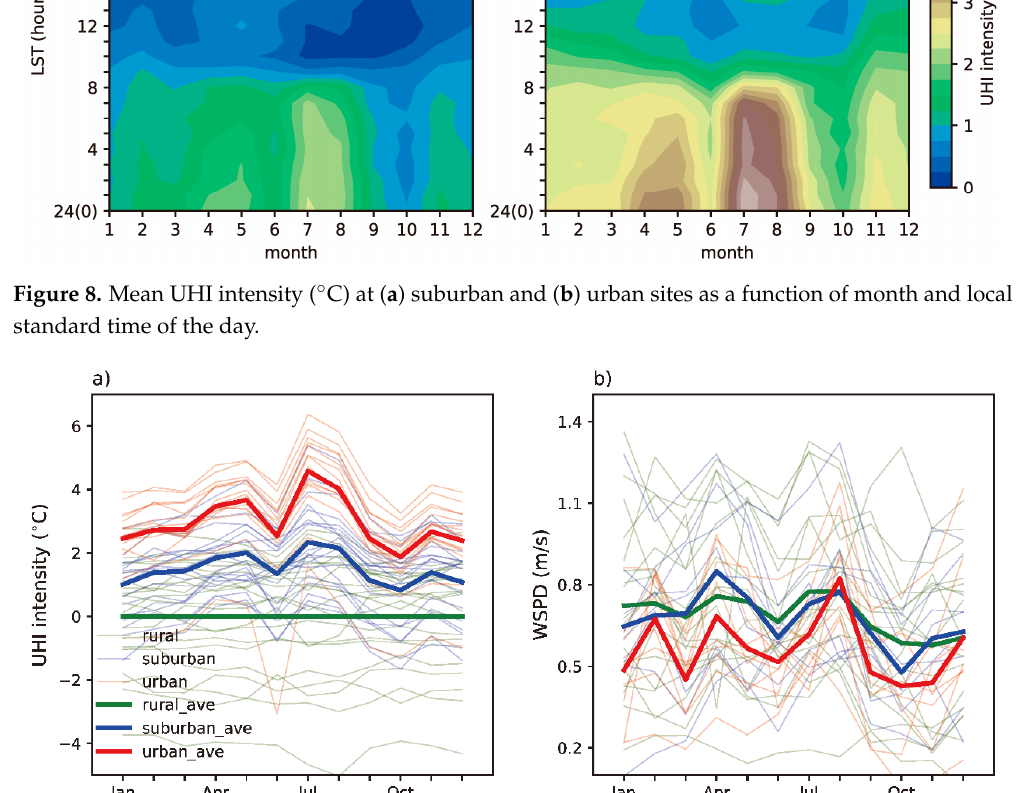
Figure 9. Mean seasonal cycle of ( a ) UHI intensity (°C) and ( b ) wind speed (m/s) at 00 LST of the day. The red, blue, and green lines indicate urban, suburban, and rural sites, respectively. Thin lines are variations of individual sites and thick lines are the averages of sites in certain categories.